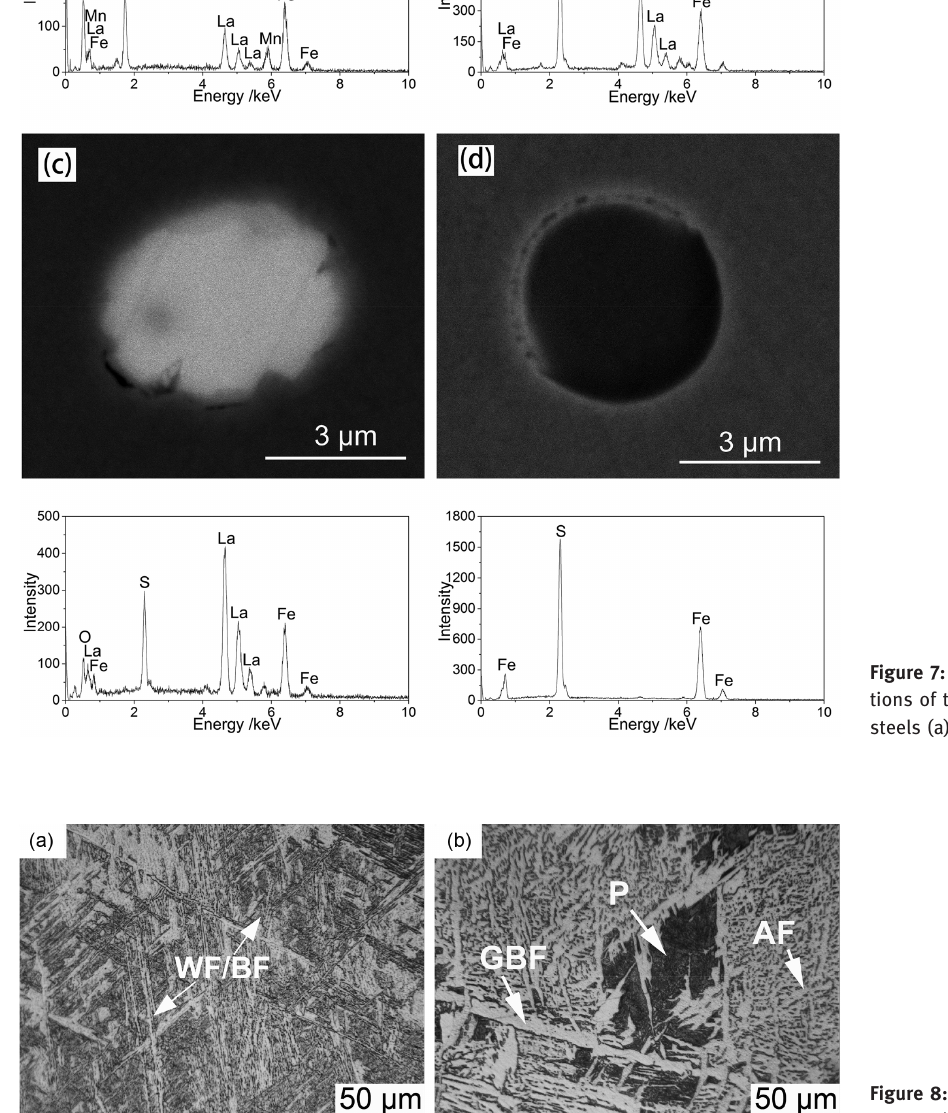
Figure 8: The typical microstructure